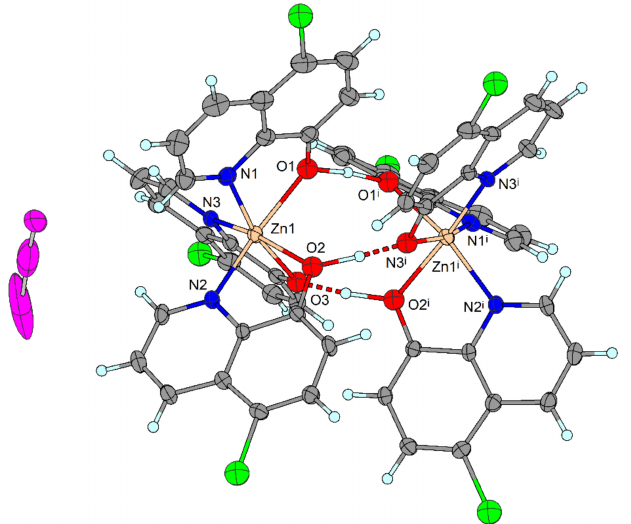
Figure 8. Molecular structure of 3 , symmetry code: i = − x + 1, y , − z + 1.5. Displacement ellipsoids are drawn at 50%